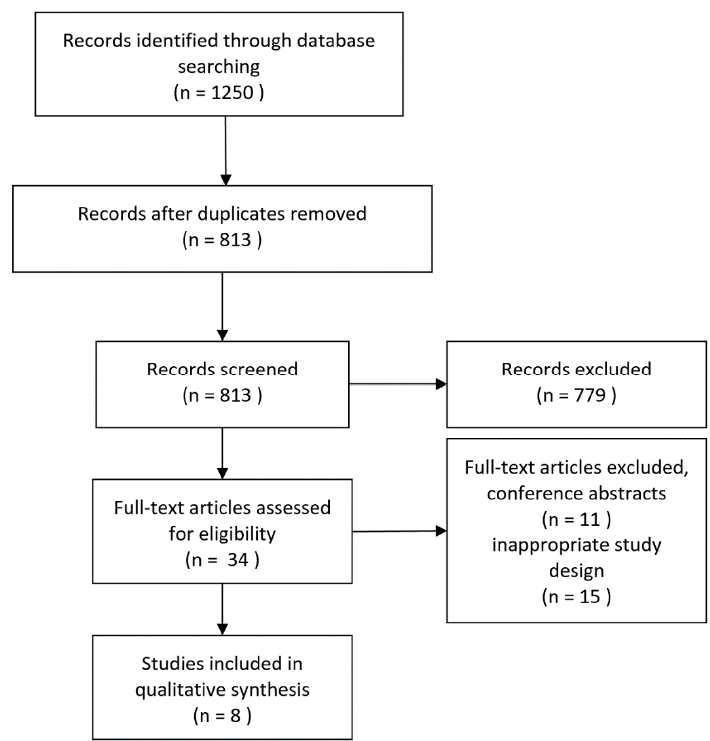
Figure 1. Flowchart of the literature review article selection process. Inappropriate study design refers to studies that did not include a well-defined LVV or atherosclerosis group or did not perform a comparative analysis between both. Table 1. Overview of the included studies and their aims and primary outcomes.